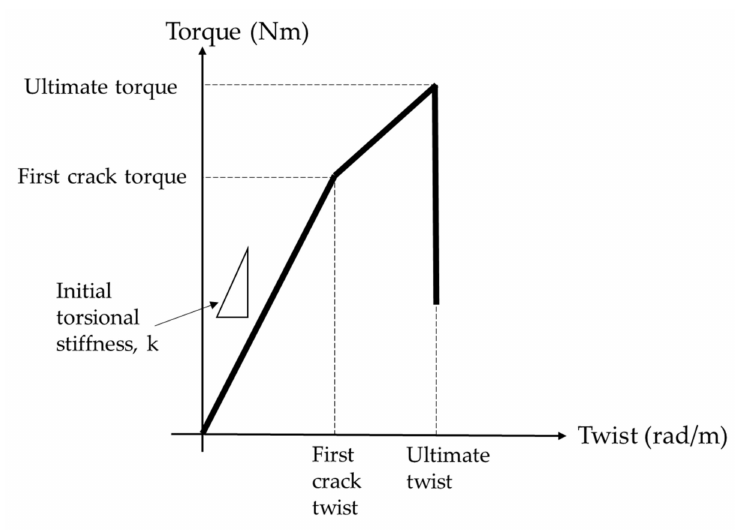
Figure 2. Torsion machine and acoustic emission method.